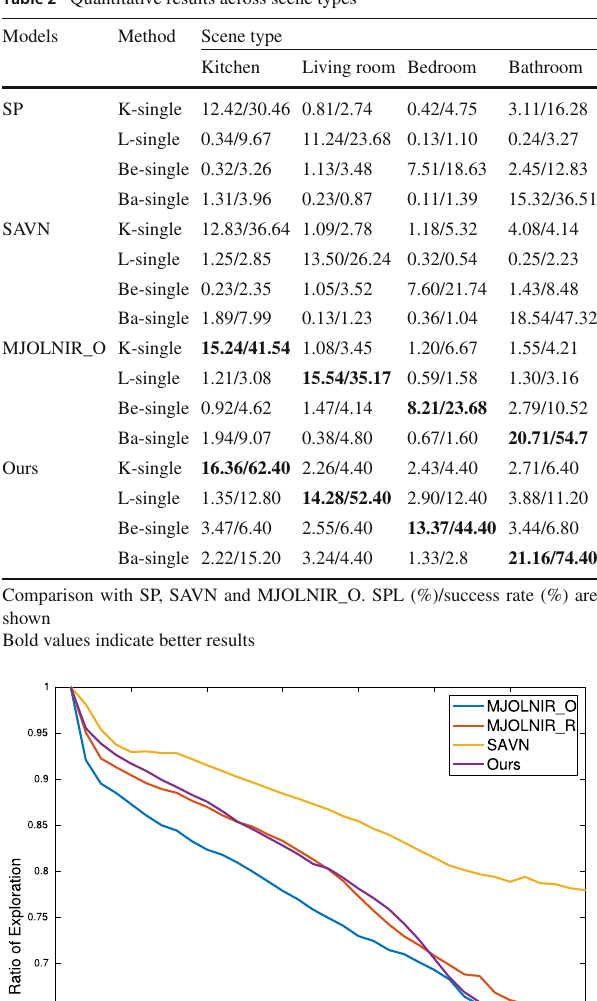
archical semantic relation input surpass the state-of-the-art method [34] for SPL by 36 .